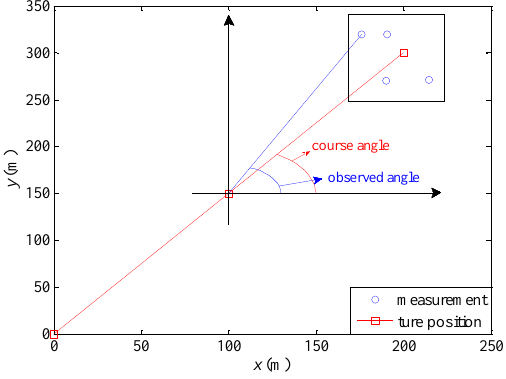
Figure 2. The course angle and the observed angle.